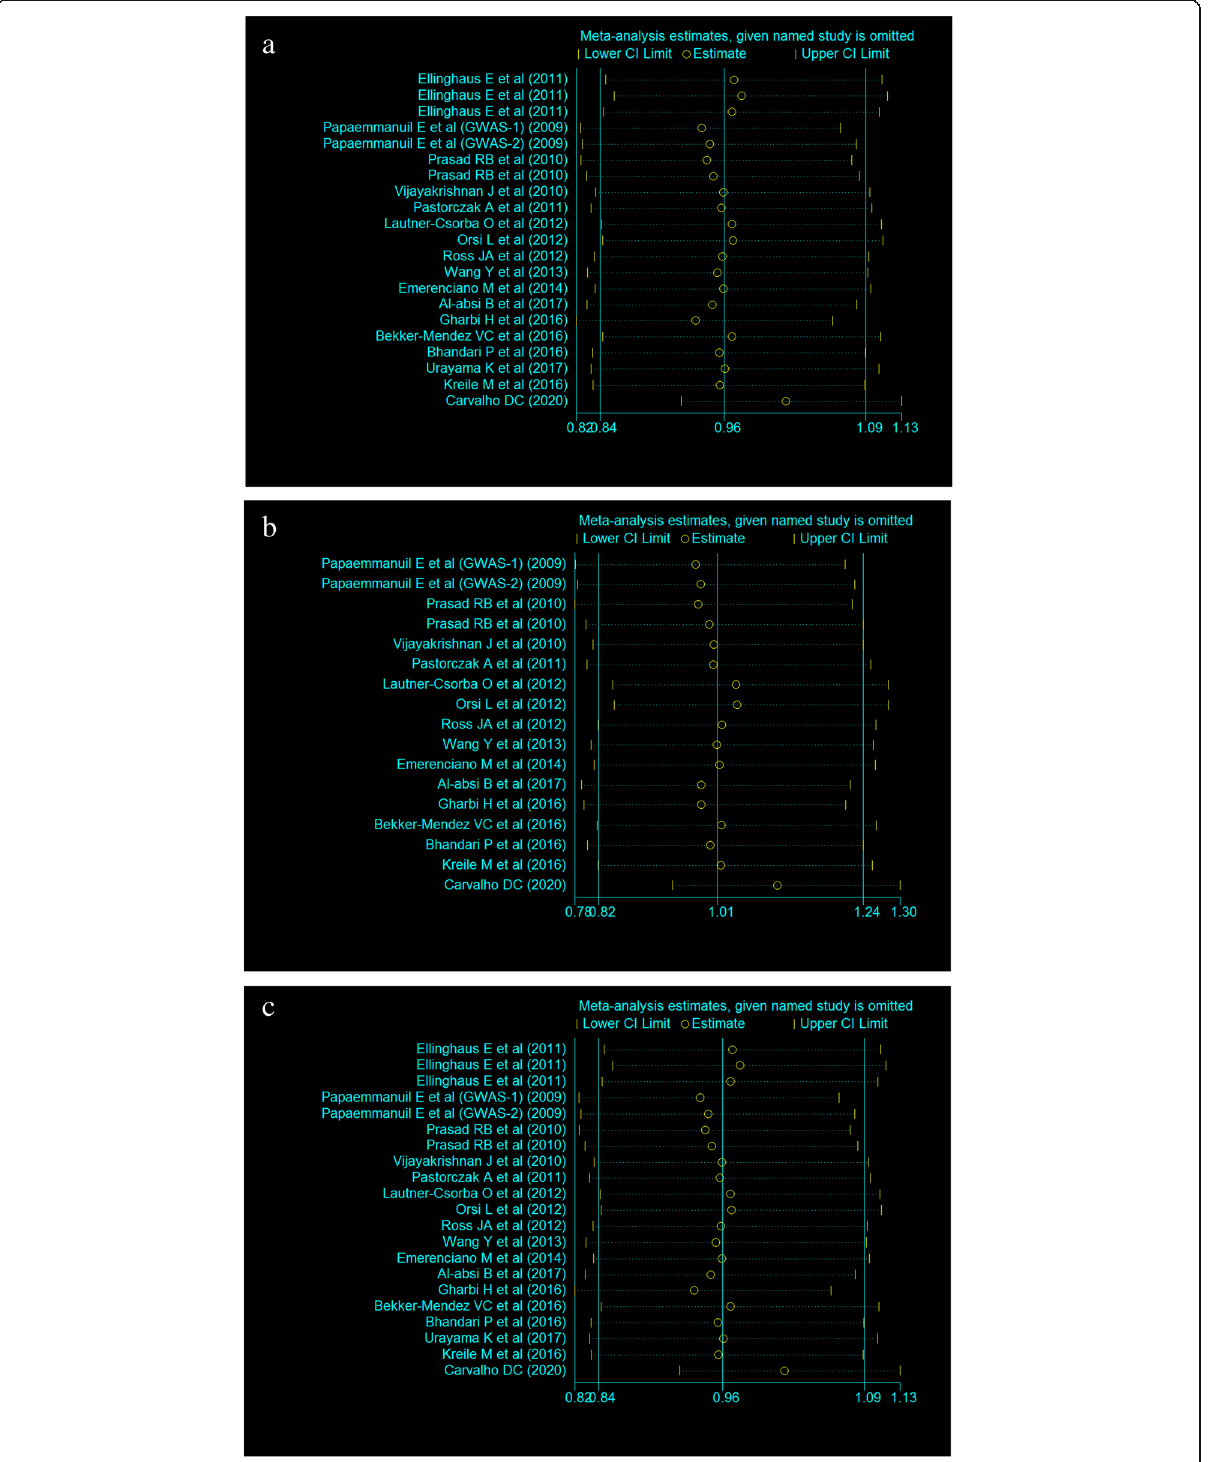
Fig. 2 Forest plots of the CEBPE rs2239633 polymorphism under different genetic models. a The model of CC vs CT + TT. b The model of CC + CT vs TT. c The model of C vs